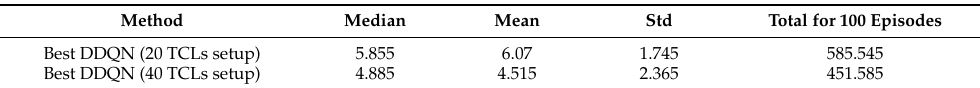
Table 5. Achieved decrease in costs compared to the competing approach (proportional control) for 200 s period, in USD × 10 − 4